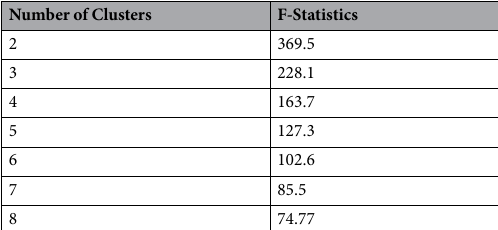
Table 4. Detailed results clustering